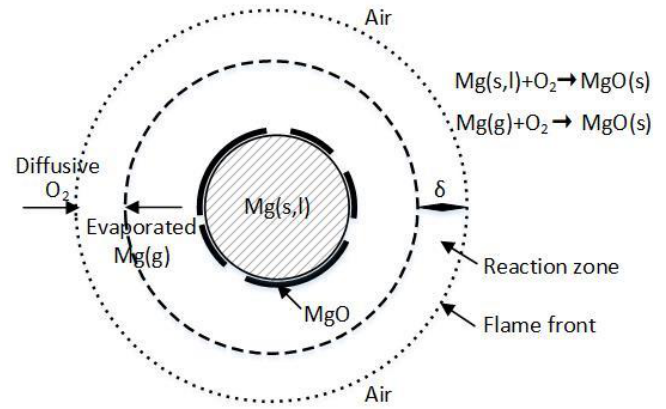
Figure 17. Schematic of physical model of individual Mg microparticle combustion.